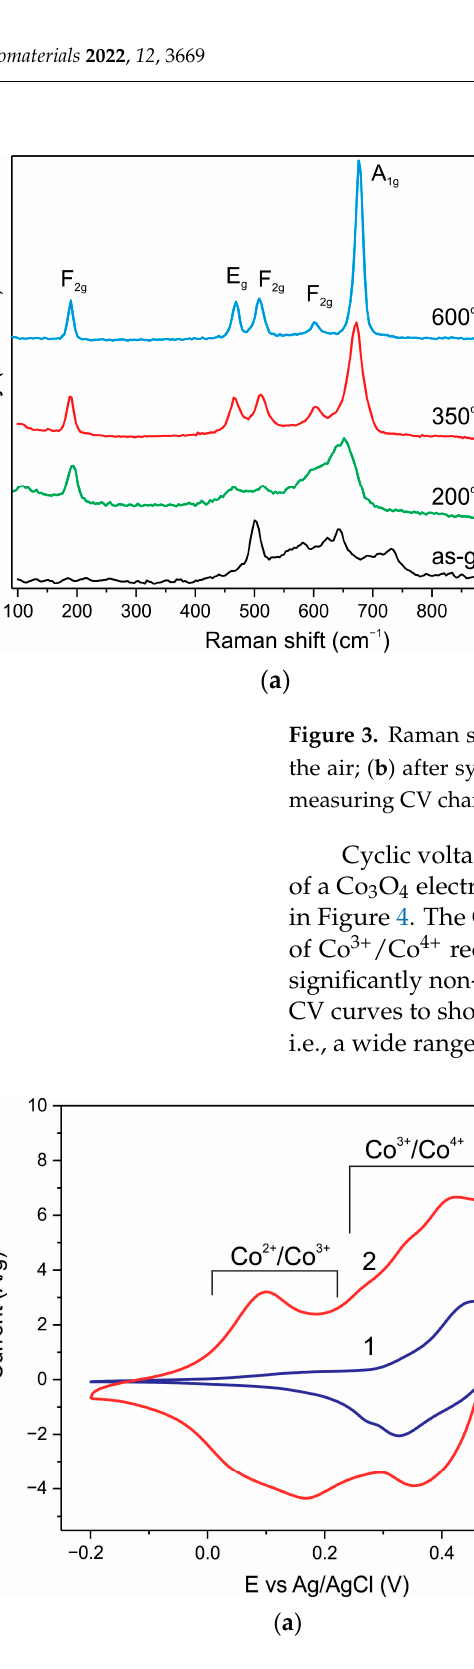
Figure 4. CV curves of the Co 3 O 4 electrode with a mass loading of 1.2 mg cm − 2 at a scan rate of 0.008 V s − 1 ( a ); Galvanostatic charge–discharge curves at current density of 1 A g − 1 ( b ), 1—before H2-treatment, 2—after H2-treatment. The approximate potential ranges corresponding to the Co 3+ /Co 4+ and Co 2+ /Co 3+ redox reactions are shown in Figure ( a ). The capacitance of the electrodes can be estimated from the CV curves using the for- mula: